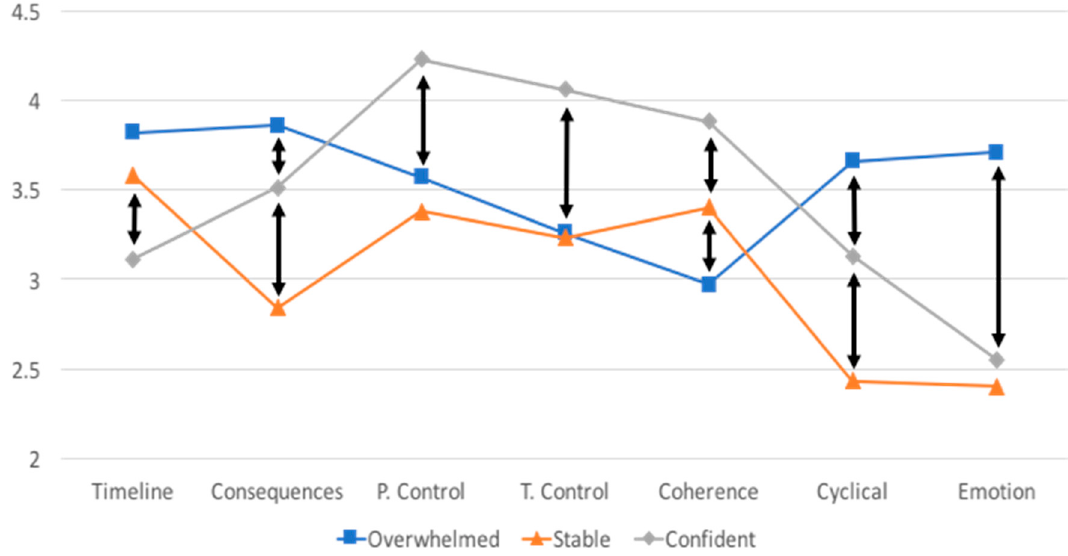
Figure 1. Latent profile analysis results. Arrows indicate statistically significant differences between groups for that subscale. Theoretical range of each subscale is 1–5.